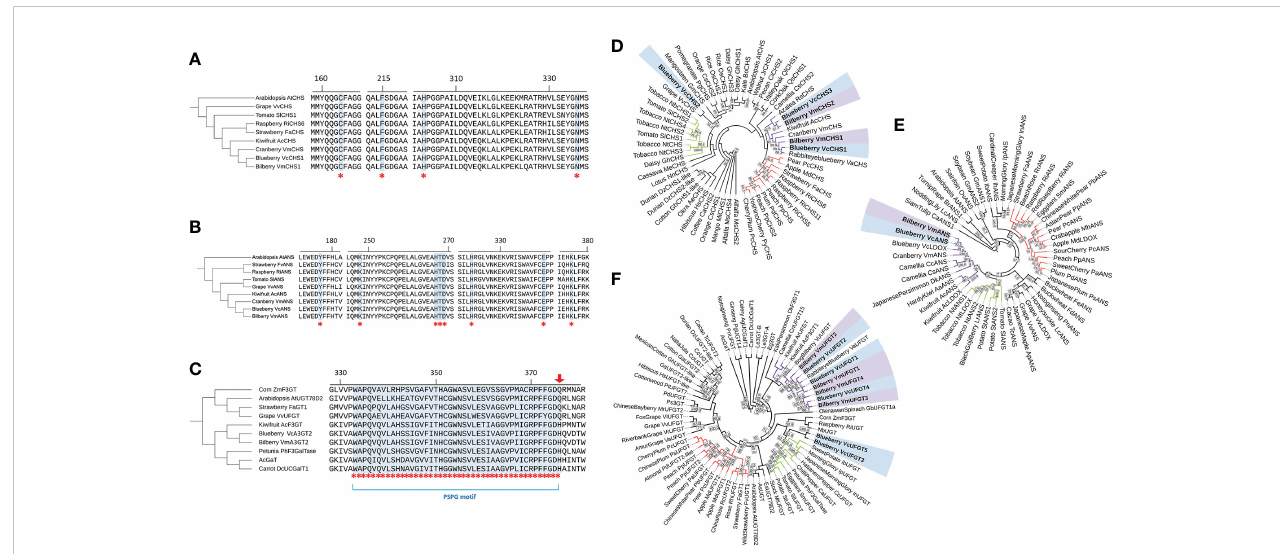
FIGURE 2 Active site alignment and phylogenetic tree of the protein sequence of CHS (A, D) , ANS (B, E) & UFGT2 (C, F) . (A-C) Active site residues are highlighted and indicated by asterisks and are referred to in the text. Arrow indicates conserved residue for glucosyltransferases/galactosyltransferases. Residue numbering is based on blueberry sequence. (B-F) : Blueberry and bilberry sequences are in bold and highlighted (blueberry – blue; bilberry – purple). Clusters of the three most represented taxonomic orders are indicated by branch colour (Rosales – red; Solanales – green; Ericales – purple; others - black). Phylogenetic trees were constructed using the Neighbour-Joining algorithm with 0.5% topology support threshold. Bootstrap analysis was performed at 10,000 replicates, values > 50% are shown on the tree. Sequence accession numbers are indicated in Supplementary Tables 2, 3 and